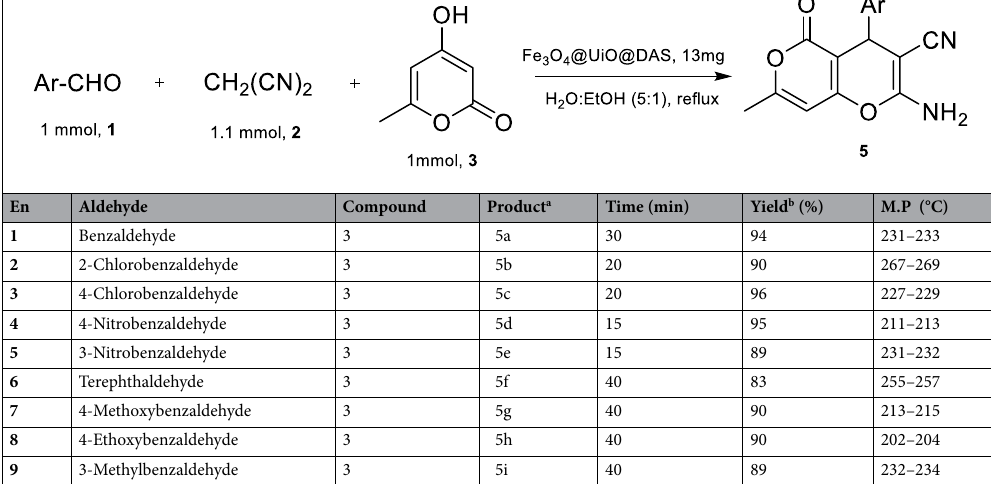
Table 3. Three-component synthesis of different 2-amino-7-methyl-5-oxo-4-phenyl-4,5-dihydropyrano[4,3- b ] pyran-3-carbonitrile (5a-i) via condensation of various aldehydes (1), malononitrile (2) and 4-hydroxy-6- methyl-2 H -pyran-2-one (3) in the presence of Fe 3 O 4 @UiO@DAS. Reaction conditions: Aldehyde (1, 1 mmol), Malononitrile (2, 1.1 mmol), 4-hydroxy-6-methyl-2 H -pyran-2-one (3) (1 mmol), and Fe 3 O 4 @UiO@DAS